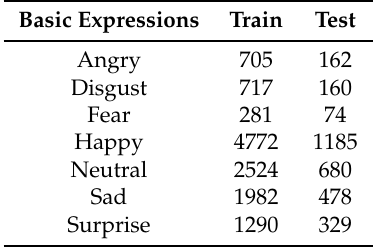
Table 2. Distribution of various samples in RAF Basic.